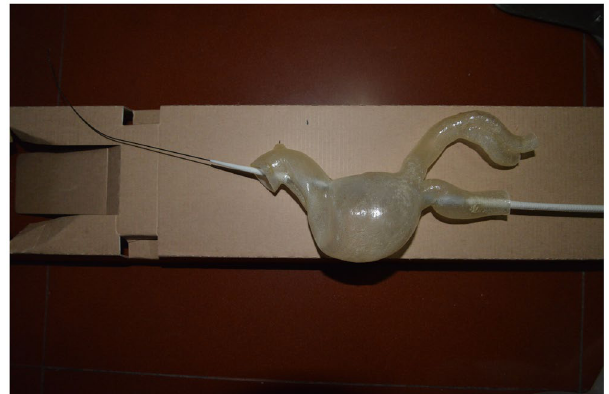
Figure 4. Illustration of a simulation surgery with a stent graft before the intervention.